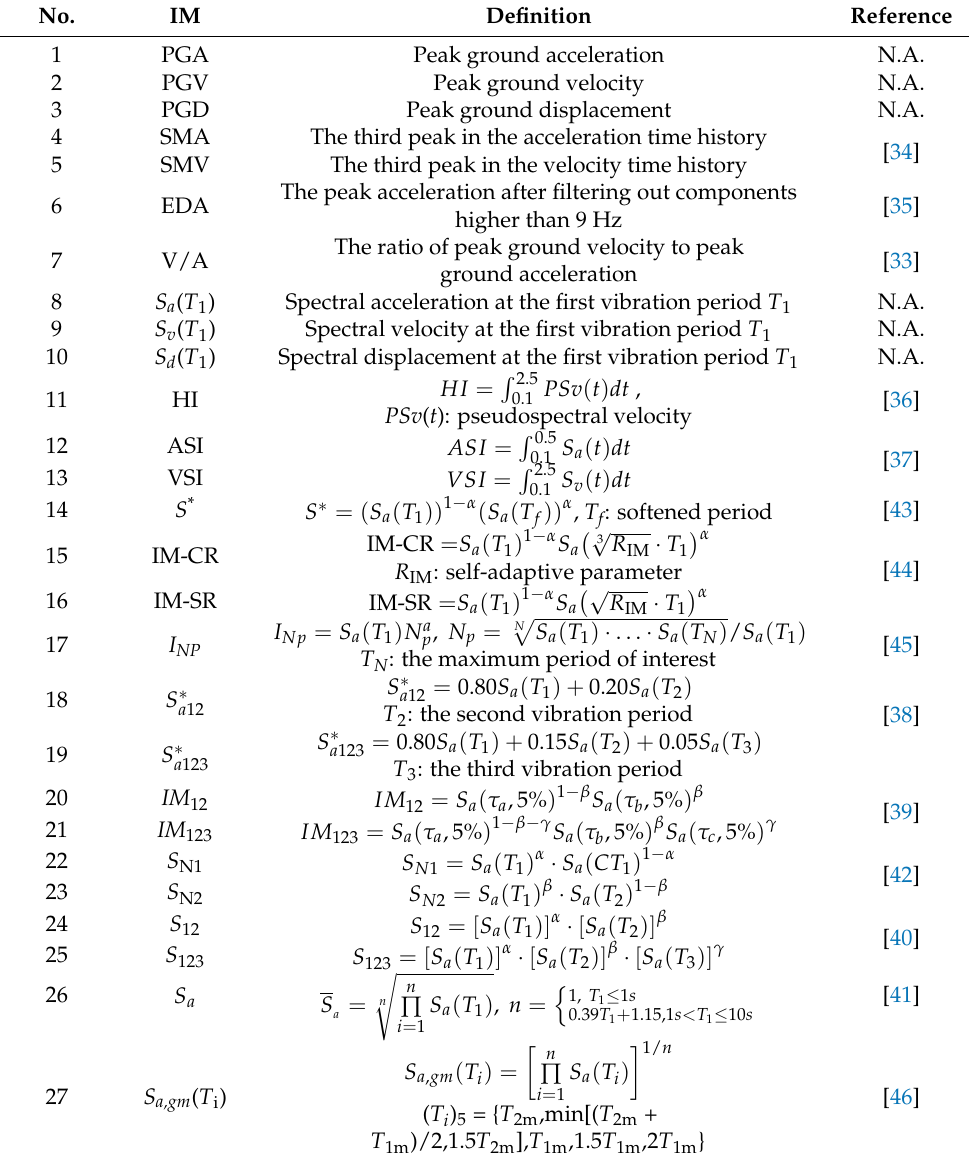
Table 4. Selected ground motion intensity